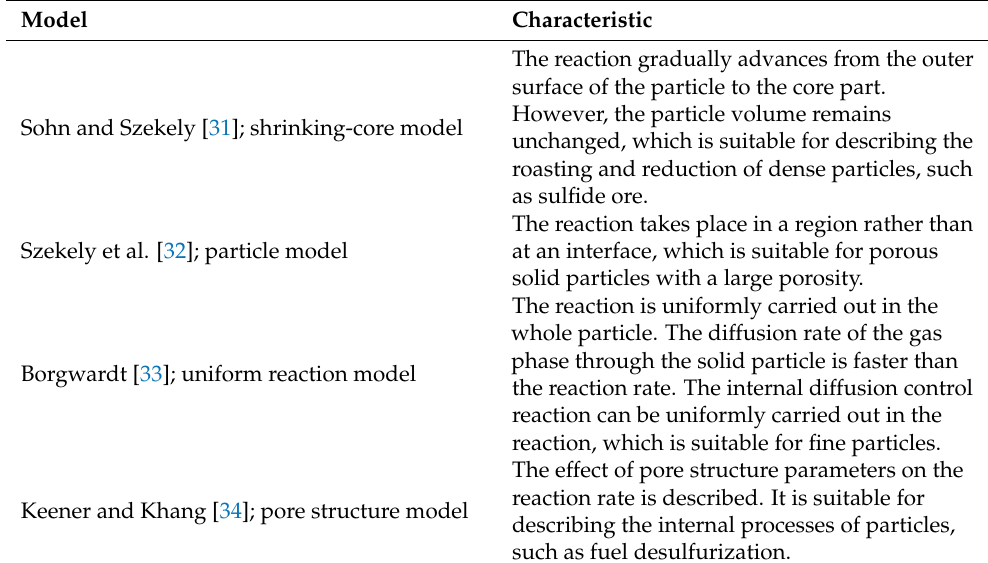
Table 1. Characteristics of different gas–solid reaction models.